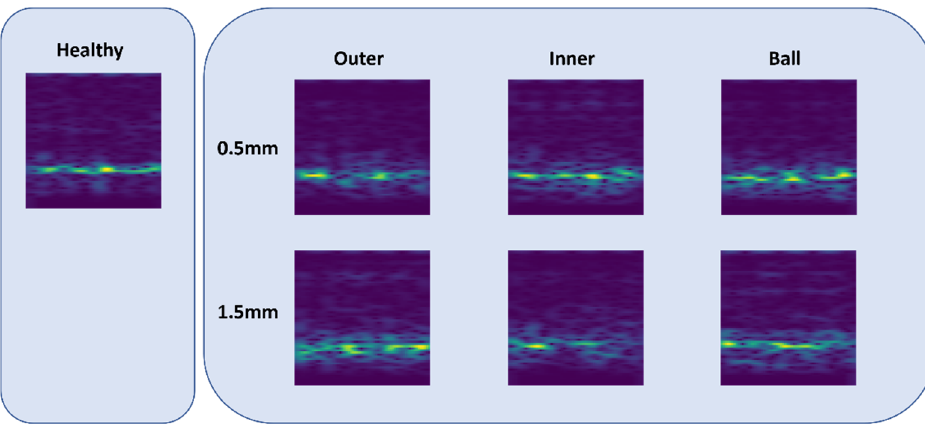
Figure 5. Example of STFT spectrograms for each class in the ESOGU dataset.